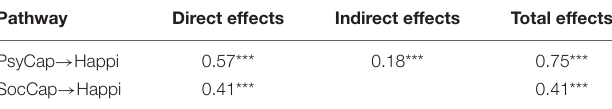
TABLE 6 | Direct, indirect, and total